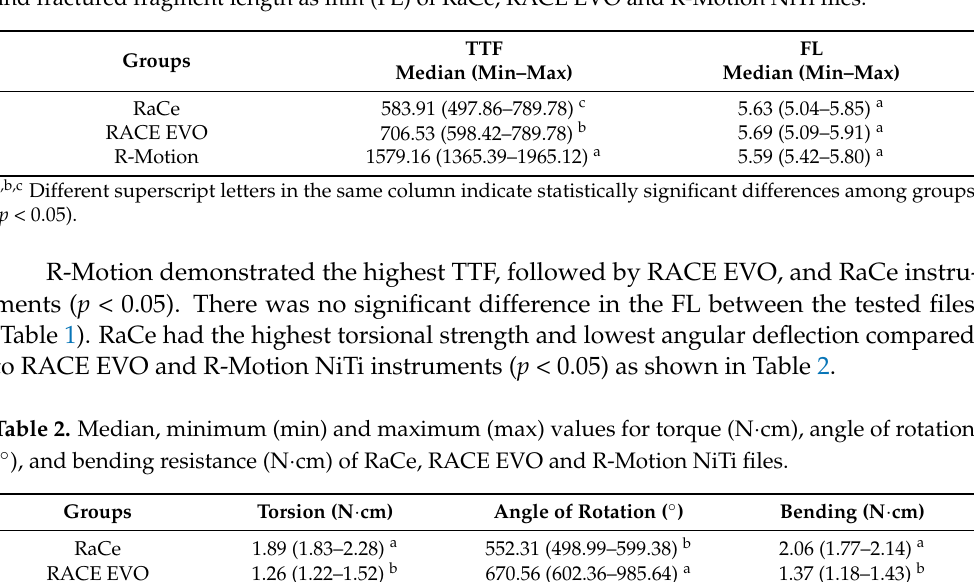
Table 1. Median, minimum (min) and maximum (max) values for time to fracture as second (TTF) and fractured fragment length as mm (FL) of RaCe, RACE EVO and R-Motion NiTi files.